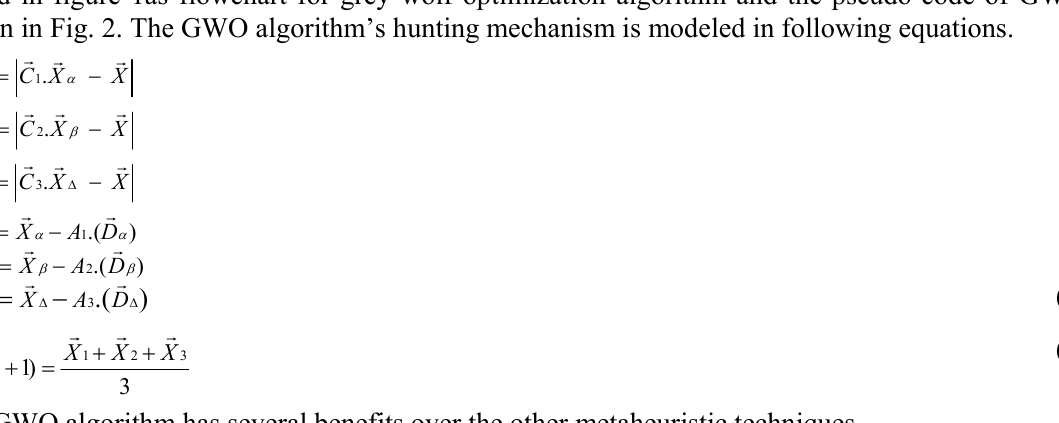
Store the best solution